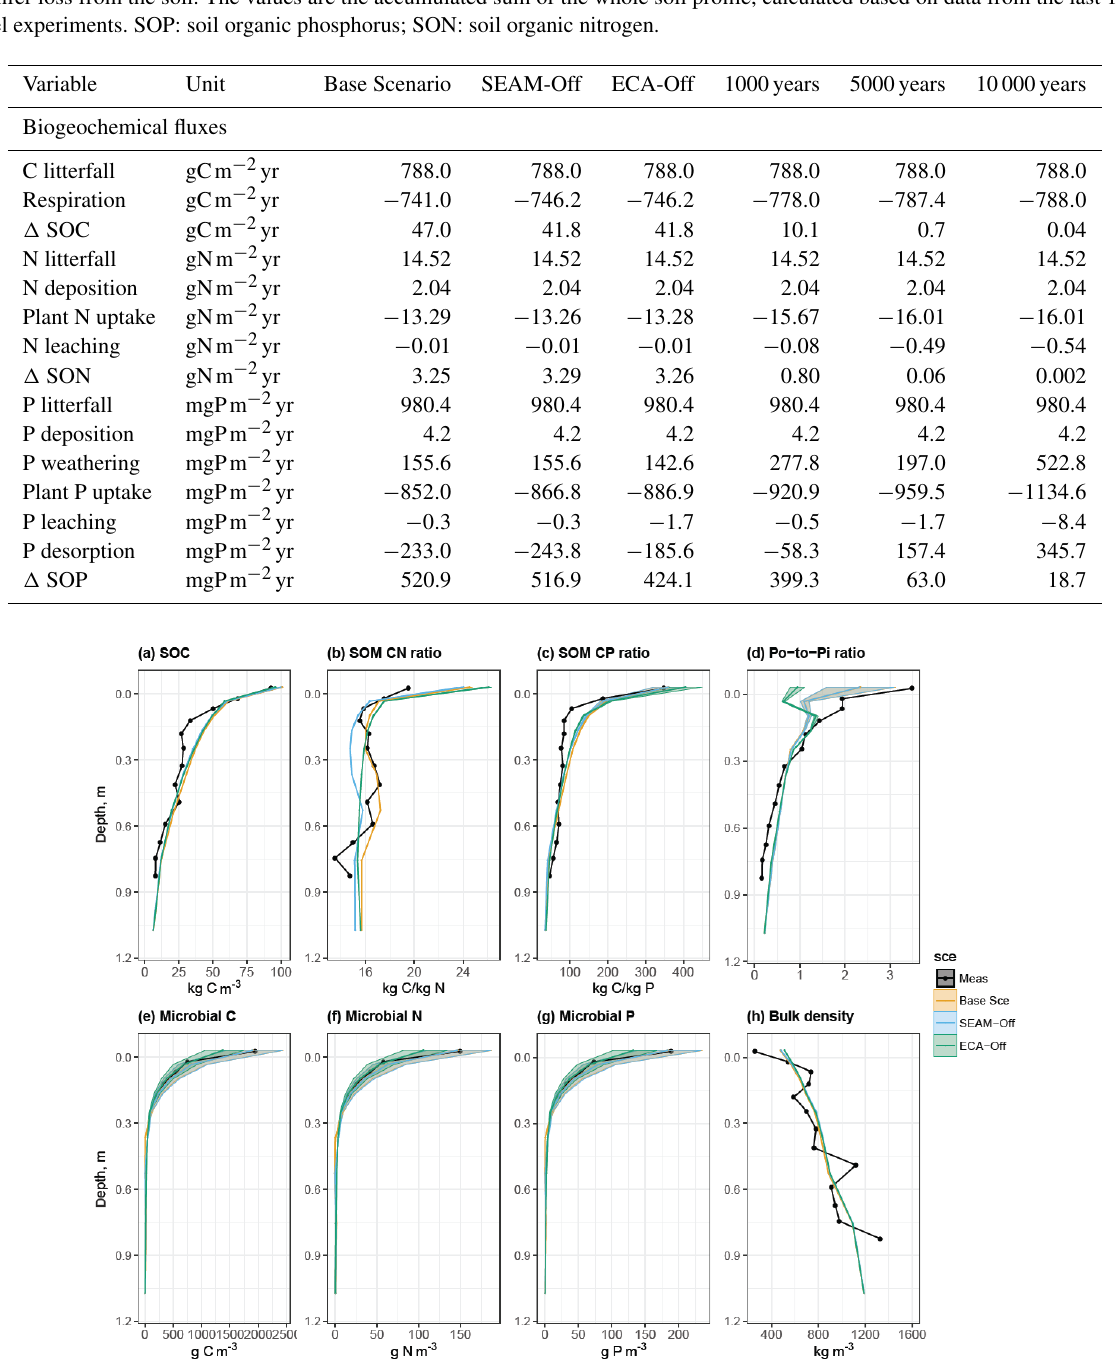
Figure 3. Simulated and observed (a) SOC content, (b) C : N ratio in SOM, (c) C : P ratio in SOM, (d) organic-P-to-inorganic-P ratio in soil, (e) microbial C content, (f) microbial N content, (g) microbial P content and (h) soil bulk density at the study site up to 1m soil depth. Black lines and dots: observations; coloured lines and shades: simulated mean values and ranges of standard deviation by different model experiments in Sect. 2.3. Microbial C, N and P values were only measured in the top 30cm of soil. Simulated means and standard deviations were calculated using data from the last 10 years of model